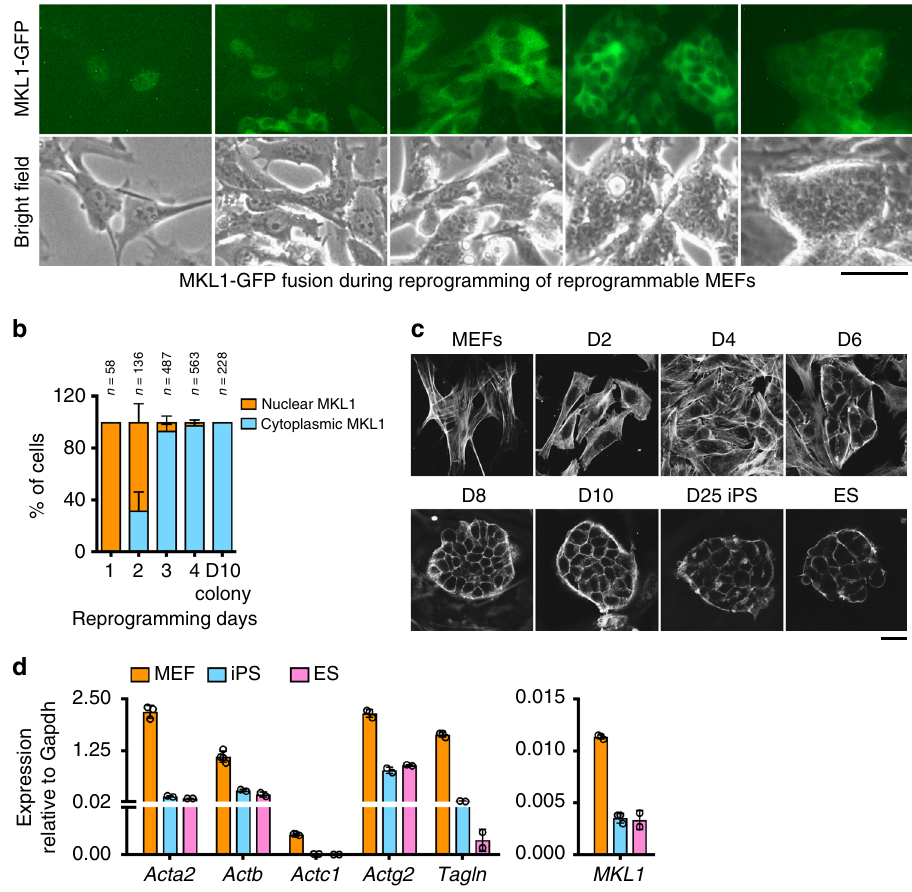
Fig. 1 Somatic cell reprogramming to pluripotency is accompanied by reduced actin-MKL1 pathway activity. a Time-course imaging of MKL1-GFP localization in MEFs undergoing reprogramming. Representative images acquired daily (day 1 – 4) during early reprogramming and on day 10 for a colony with iPS-like morphology. Note MKL1-GFP gradually localizes to the cytoplasm as reprogramming progresses. Scale bar: 50 μ m. b Quanti fi cation of the % of cells displaying nuclear- or cytoplasmic-localized MKL1-GFP in a . Images from three independent experiments were analyzed, and data were pooled from the indicated numbers of cells for each condition. c Representative confocal images of reprogramming cultures stained with phalloidin (F-actin) through the time course (MEF, day 2, day 4, day 6, day 8, day 10, and day 25). A typical ESC colony was stained as a control. Scale bar: 20 μ m. d Realtime QPCR analyses of the mRNA levels of actin related genes, as well as MKL1 itself in MEFs, iPSCs and ESCs. Data are representative of three independent experiments. Error bars denote standard deviation of triplicate samples ( n = 3) in each